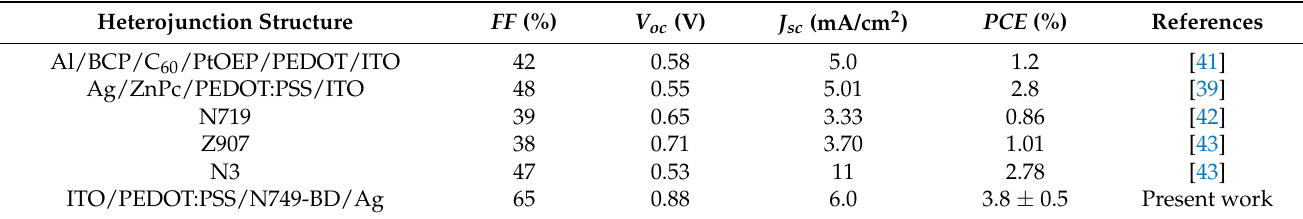
Table 3. Comparison of parameters of ITO/PEDOT:PSS/N749-BD/Ag solar cells with previously reported solar